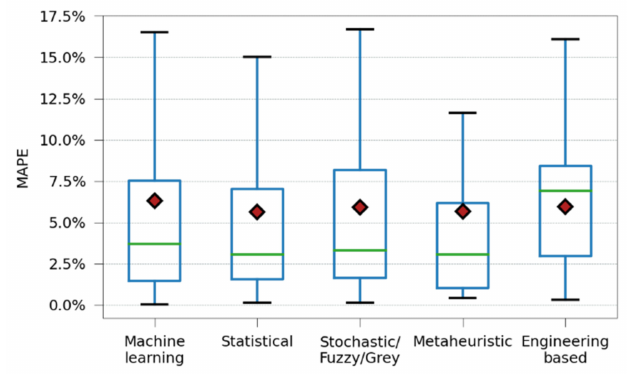
Figure 10. Boxplot of MAPE values by categories of techniques. Box represents the interquartile range (IQR). Whiskers show a range of data beyond the 1st and 3rd quartile and extend until 1.5*IQR on each side, ending at maximum and minimum data points within that interval. Outliers are not shown. The green line represents the median. The red diamond represents mean. Among the analyzed articles, accuracy measured by MAPE does not seem to depend necessarily on the chosen technique.